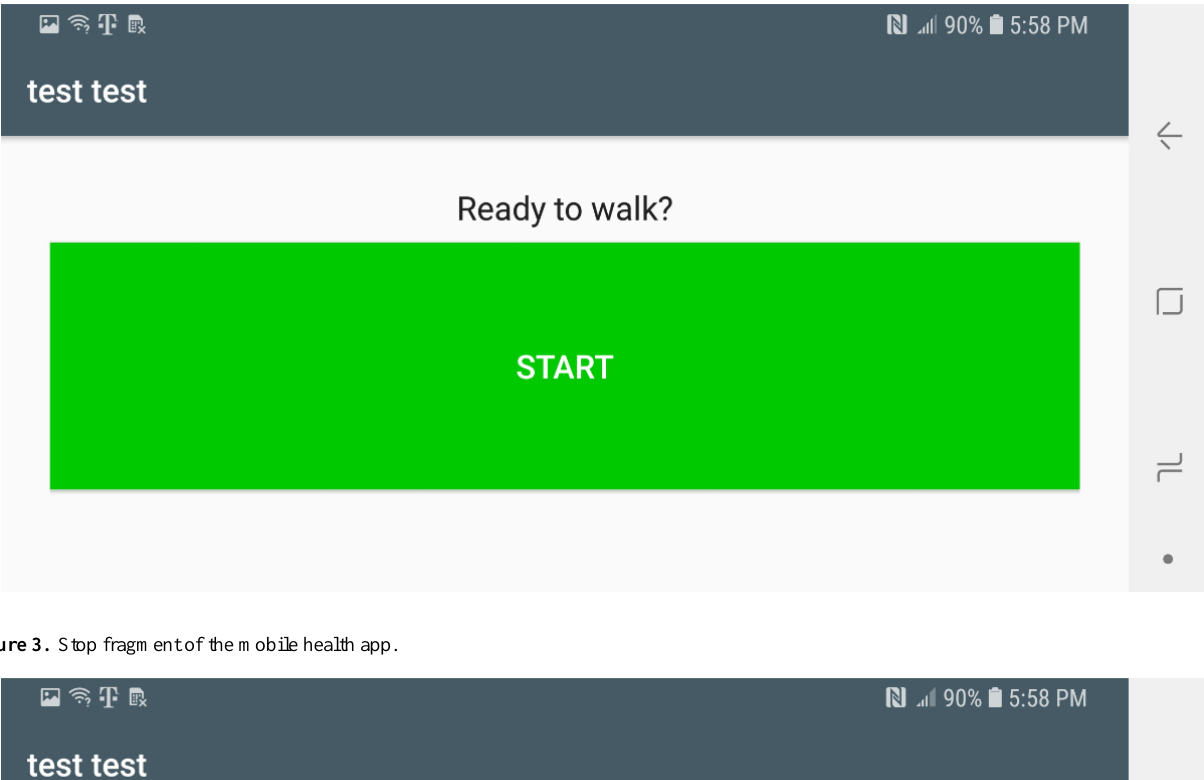
Figure 2. Start fragment of the mobile health app.